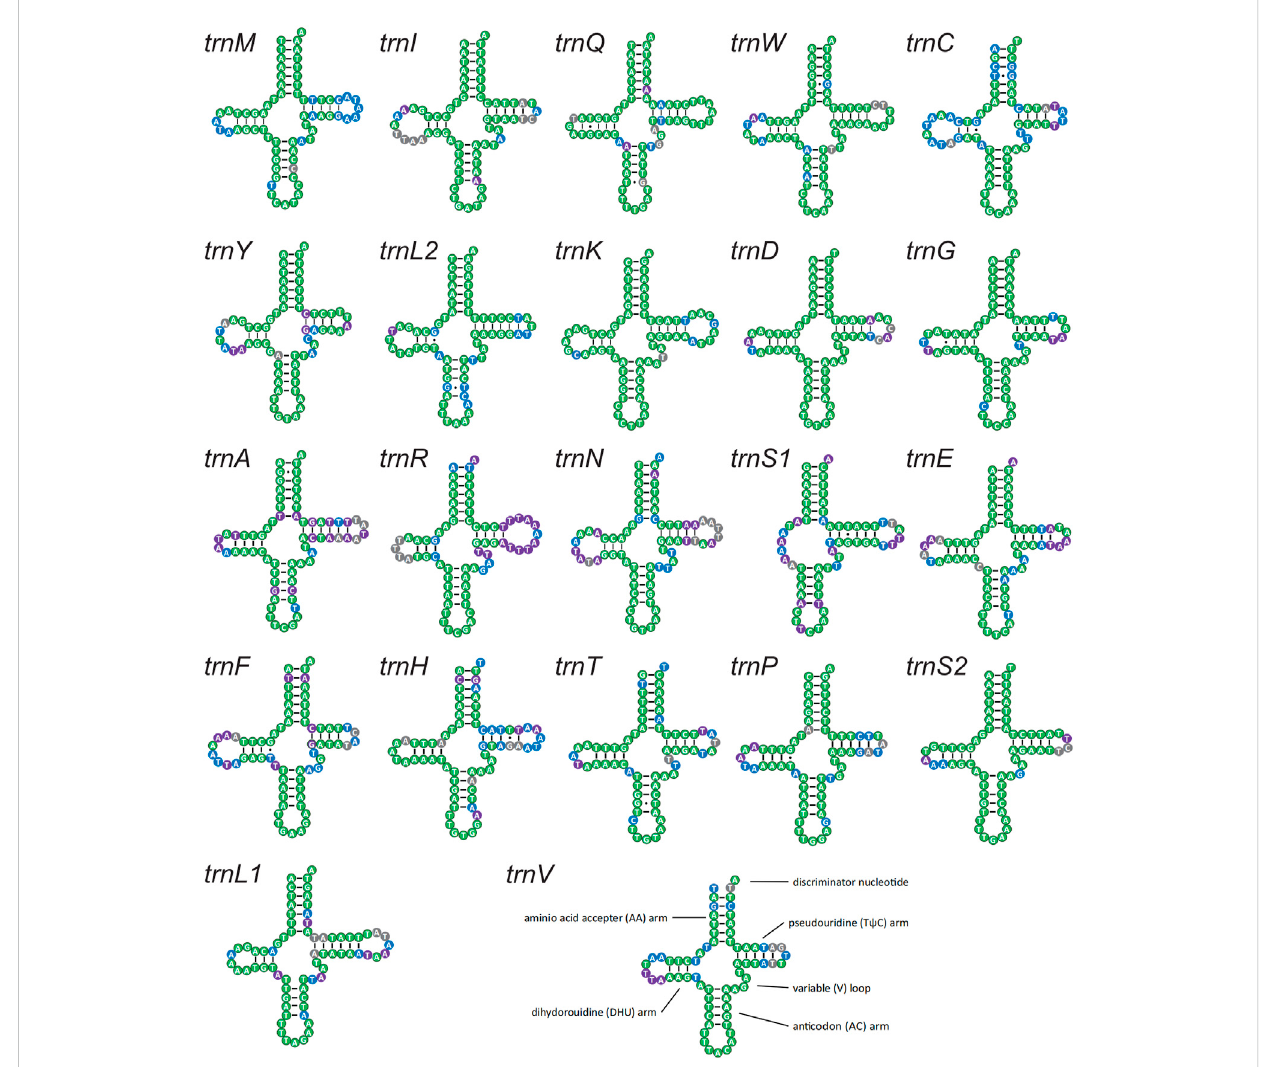
FIGURE 7 Putative secondary structures of the22 tRNA genes identi fi ed in themitochondrial genome of Lycaenidae. All tRNA genes are shown in theorder of occurrence in the mitochondrial genome starting from trnM . The nucleotides showing 100% identity within Lycaenidae, Polyommatinae, and QTP species are marked in green, blue, and purple, respectively. Bars indicate Watson – Crick base pairings, and dots between G and T pairs mark canonical base pairings in